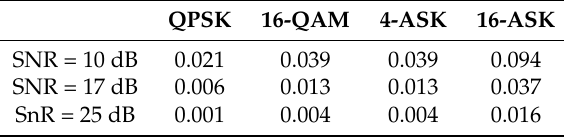
Table 1. BER comparison of OFDM systems under investigation at different SNRs for CFO = 0.05.